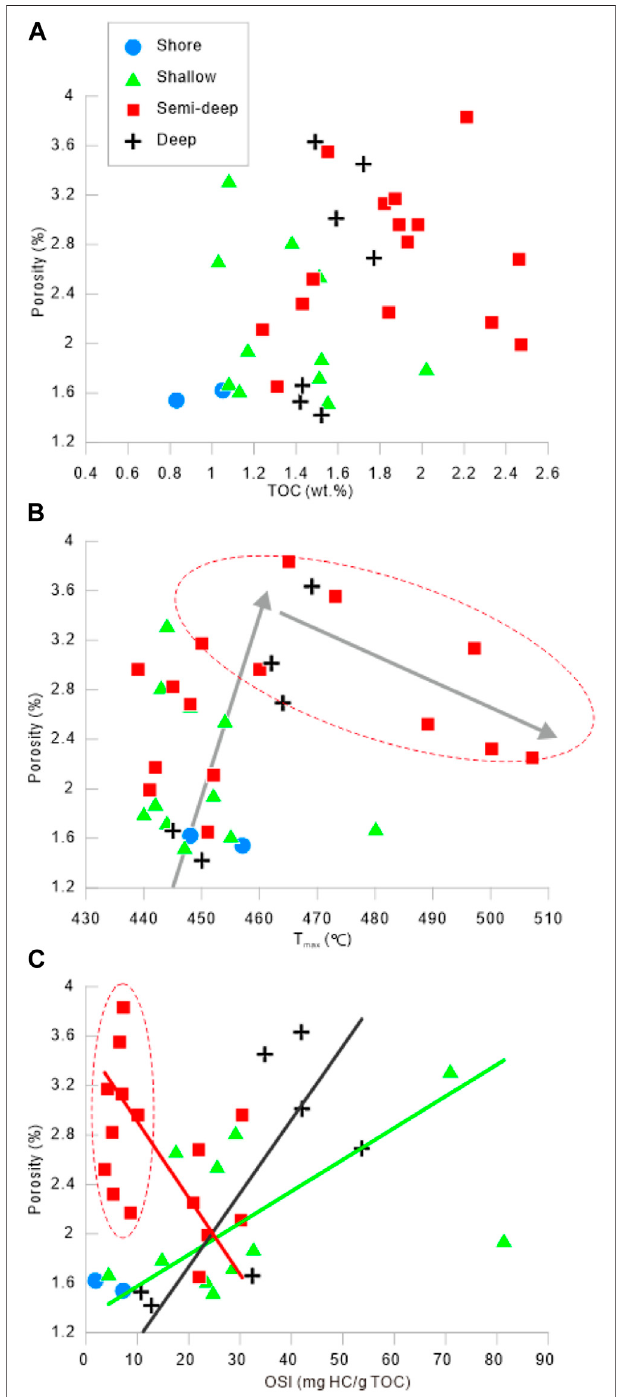
FIGURE 12 | Cross plots of (A) TOC content with the hydrocarbon generatingpotential(S 1 +S 2 ) (B) TOCcontentwithOSI,and (C) T max withOSI of the black shale of the Dongyuemiao member.